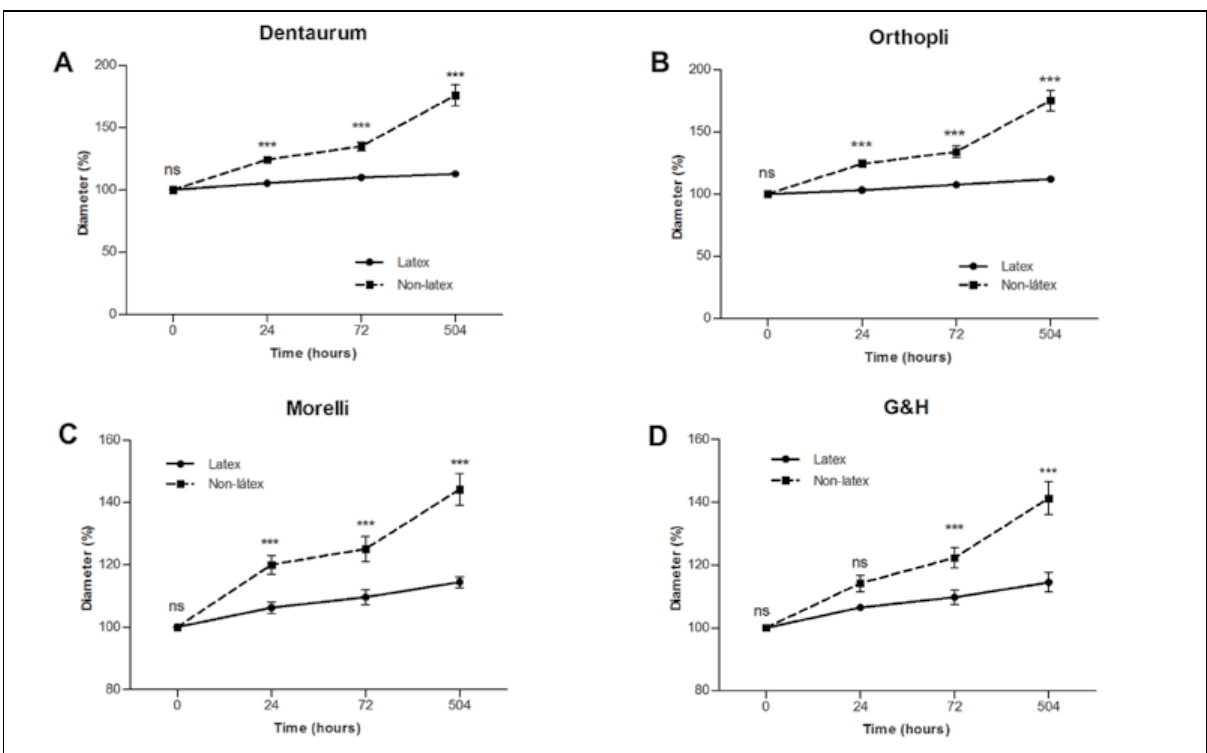
Figure 6. Comparison between the means of internal diameter deformation (%) of the elastic latex and non-latex: Dentaurum, Orthopli, Morelli and G&H, in all experimental periods. *** p < 0.001; ns = not